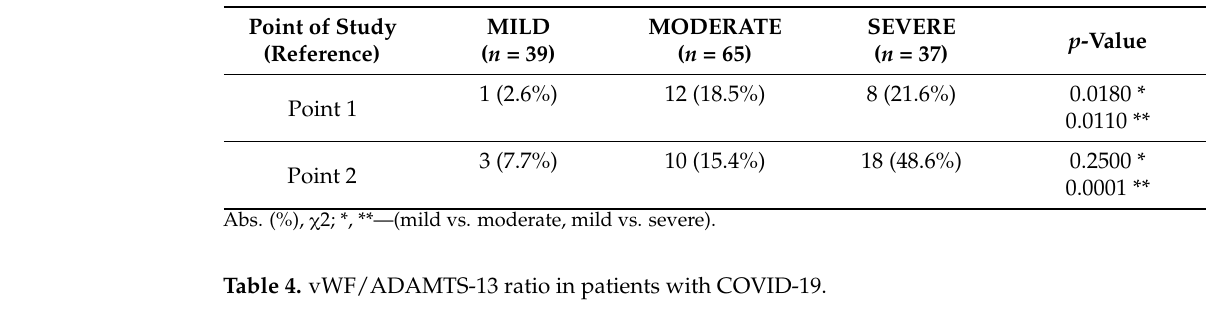
Table 3. Decreased ADAMTS-13 blood level in patients with moderate and severe COVID-19.